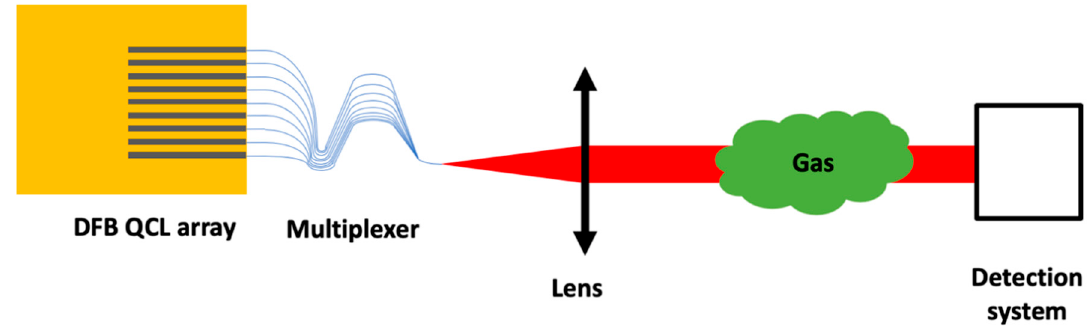
Figure 6. Schematic of a DFB QCL array source with multiplexer for gas detection.